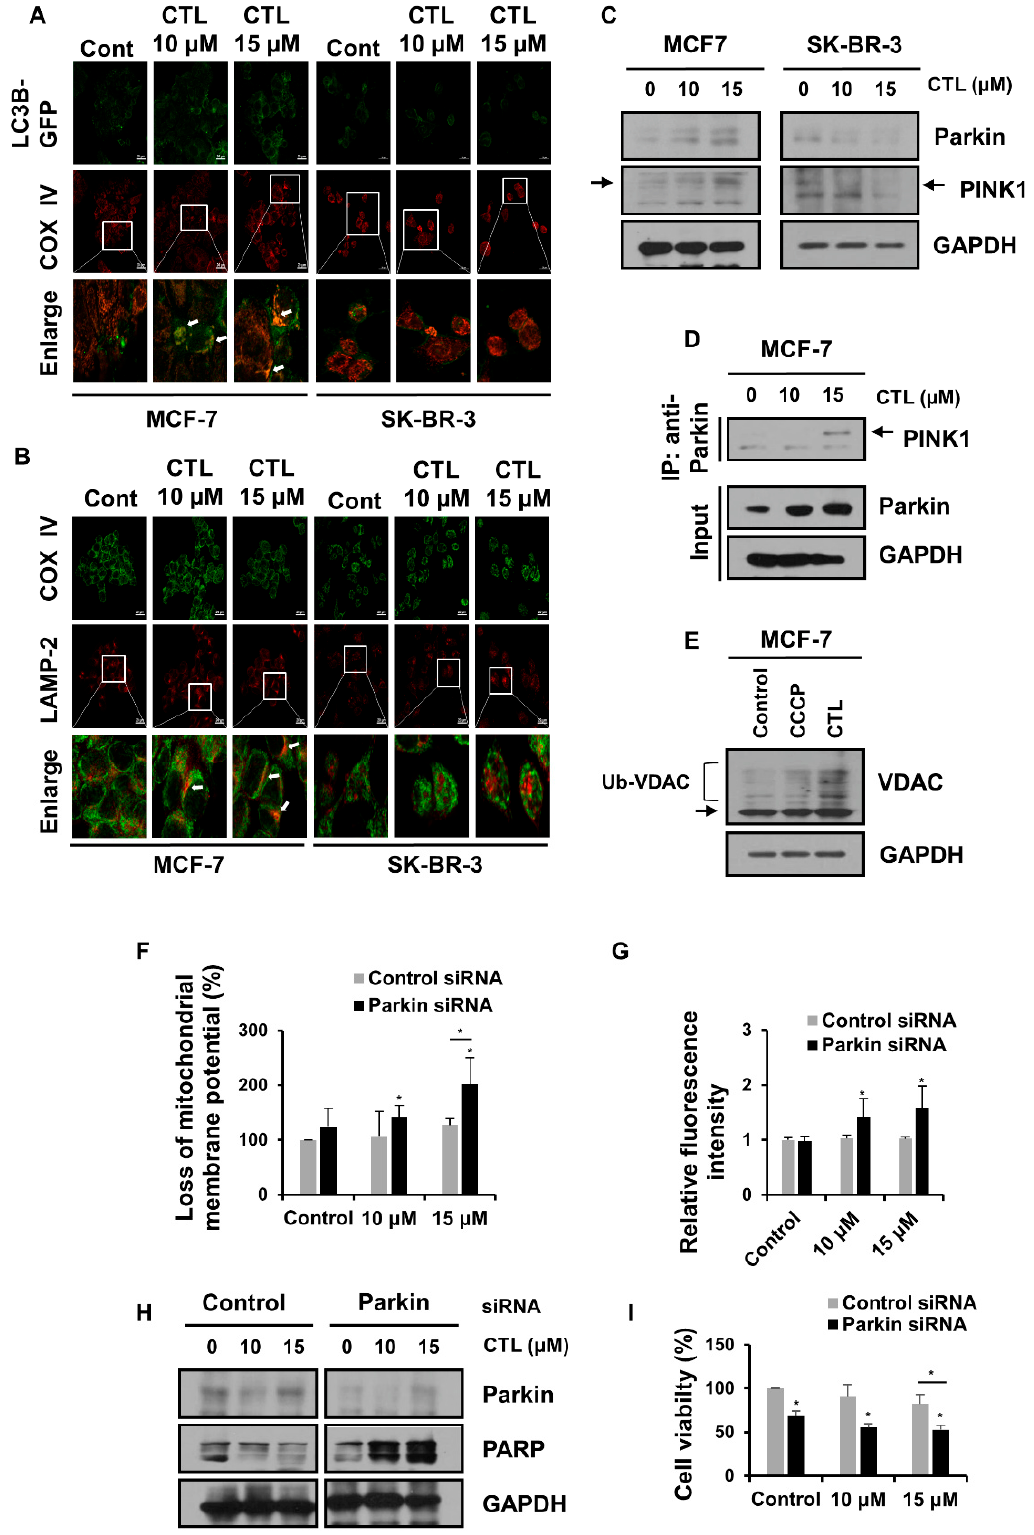
Figure 4 . MCF-7 cells activate PINK1/Parkin-dependent mitophagy as a defense mechanism against CTL-induced ROS production. ( A ) MCF-7 and SK-BR-3 cells were transfected with LC3-GFP (autophagosome marker, green) for 24 h and treated with CTL for another 24 h. Cells were immunostained with anti-COX IV (mitochondrial marker, red). ( B ) Cells were treated with CTL for 24 h and then stained with anti-COX IV (green) and anti-LAMP2 (lysosome marker, red). The images were analyzed using confocal microscopy (Carl Zeiss, Jena, Germany) at ×40 magnification. The white rectangle highlights the